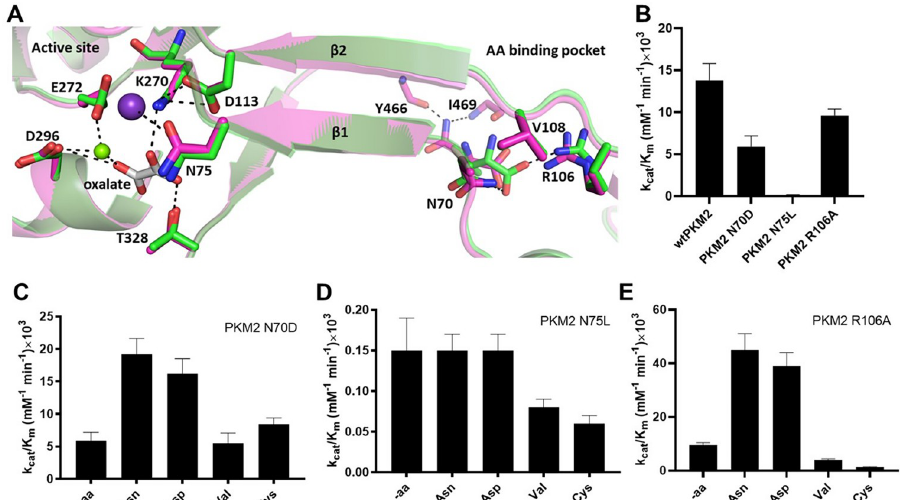
Fig 1. Proposed signal transfer pathway and differential effect of activating (Asn/Asp) and inhibiting AAs (Cys/ Val) on PKM2 variants. (A) Proposal for long-range signal transduction pathway between the allosteric AA binding site (right) and active site (left) of PKM2, based on the crystal structures of PKM-Asn (magenta) and PKM2-Val (green). The two sites are connected by two β strands, β 1 and β 2. The violet and green spheres represent K + and Mg 2+ , respectively. The dashed lines represent H-bonds. O, N and C are in red, blue, and backbone color, respectively. (B) Comparison of catalytic efficiencies ( k cat /K m ) of wtPKM2, PKM2 N70D, PKM2 N75L, and PKM2 R106A. wtPKM2 and PKM2 R106A show comparable activities, whereas PKM2 N70D and PKM2 N75L exhibit lower activity than wtPKM2. (C) The activity of PKM2 N70D increased in the presence of Asn/Asp, but Val/Cys do not impact the activity. (D) The k of PKM2 N75L is influenced in the presence of Val/Cys slightly but Asn/Asp have no effect. cat /K M (E) The activity of PKM2 R106A is influenced by the activating and inhibiting AAs in a similar manner as that of wtPKM2, with k cat /K M increasing with Asn/Asp, whereas Val/Cys inhibit the variant. The activity assays were performed with 65 nM PKM2 N70D, 4200 nM PKM2 N75L, and 50 nM PKM2 R106A. The concentration of PEP was varied between 0.025–8 mM and the ADP concentration was kept constant at 0.8 mM for all assays. The AA concentrations were fixed at 2 mM for all experiments, with the exception of PKM2 R106A, where 10 mM Val was used. The kinetic data were used to calculate the catalytic efficiencies. Kinetic parameters are listed in S1 Table.